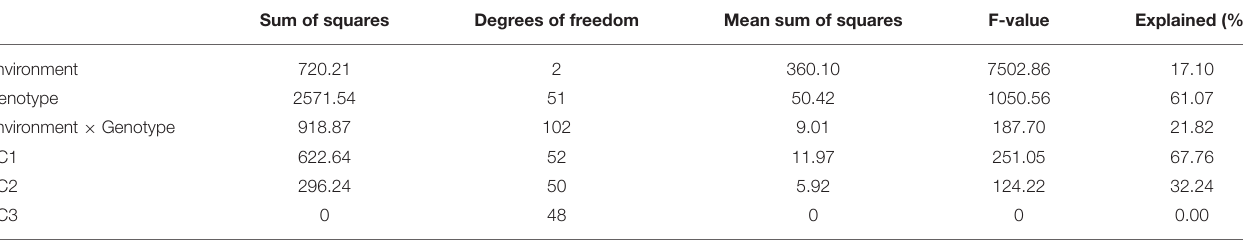
TABLE 4 | AMMI analysis of variance for mean grain yield of 52 mungbean genotypes from three different locations during Kharif 2017, 2018, and 2019. Sum of squares Degrees of